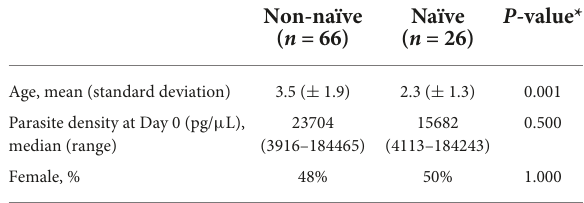
TABLE 1 Characteristics of children with P. falciparum infection stratified into exposure naïve and exposure non-naïve.